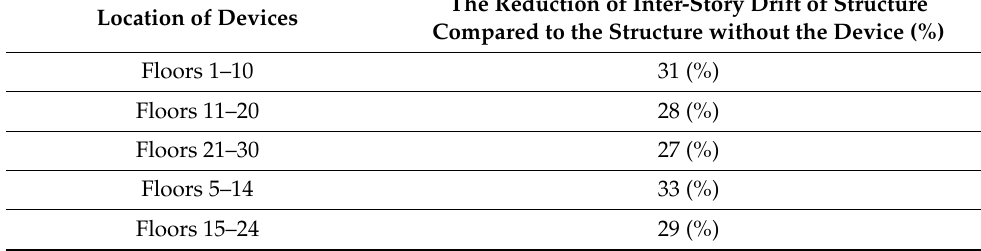
Figure 23. Devices on floors 5 to 14: ( a ) Inter-story drift ratio; ( b ) Floor acceleration at 30th floor. Table 1. Inter-story drift of structure compared to its without device.